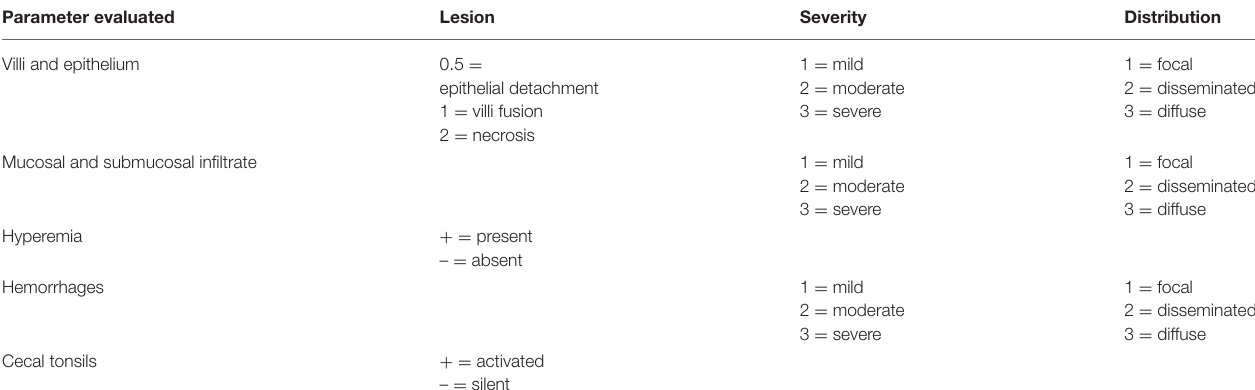
TABLE 2 | Histopathological scoring system used for the evaluation of intestinal tissues in broilers. Each parameter was evaluated for all chickens in ileum, cecum, and colon. Parameter